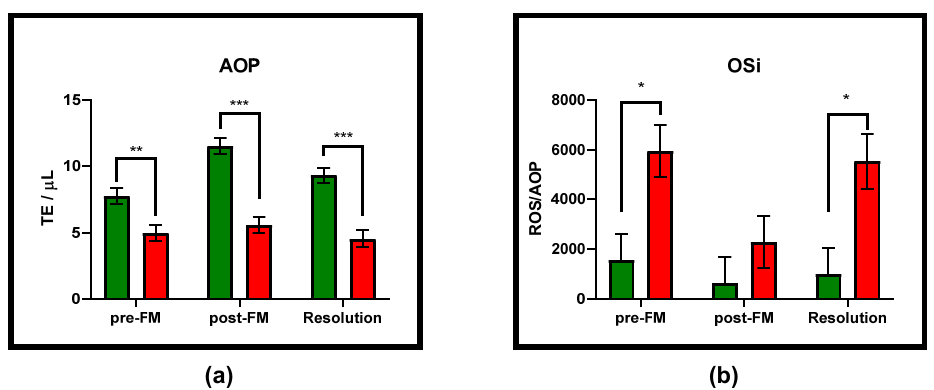
Figure 2. Concentrations (mean ± SEM) of milk biomarkers that differed between the infection outcome groups (green bars = survived; red bars = died) at any of the sampling timepoints: ( a ) AOP was elevated among cows that survived at all three timepoints; ( b ) the OSi was elevated pre-FM treatment and at resolution among cows that died, but not post-FM treatment. * p < 0.05, ** p < 0.01, and *** p < 0.001. In milk, 8-iso-15(R)-PGF2 α and 8-iso15-keto-PGE2, as well as 5-iso-iPF2 α -VI and 8,12-iso-iPF2 α -VI, were detected and contributed to the total IsoP values. Eight-hour treatment with FM decreased overall 5-iso-iPF2 α -VI and 8,12-iso-iPF2 α -VI concentrations ( p = 0.0024 and p = 0.0039, respectively), as well as the total IsoP concentration ( p = 0.0017) from pre- to post-treatment (Table 3). Strikingly, the discrete analysis of infection outcome groups revealed that none of the IsoP detected, nor the total IsoP concentration, changed pre- to post-FM treatment in animals that died of the infection. Whereas 5-iso-iPF2 α -VI, 8,12-iso-iPF2 α -VI, and total IsoP were decreased after at 8 h post-FM treatment ( p = 0.0064, p = 0.0131, and p = 0.0084, respectively). However, at no sample time were any of the individual IsoP, or the total IsoP, different from one another. Table 3. Milk biomarkers of oxidative stress over the course of systemic coliform mastitis with FM treatment in Holstein cows. (a) All animals Concentrations Pre-FM Treatment ( N = 8) Post-FM Treatment ( N = 8) Resolution ( N = 7) Biomarker (nM) Mean SEM Mean SEM Mean SEM 5-iso-iPF2 α